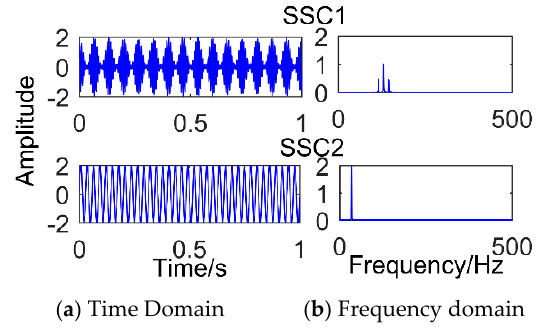
Figure 1. Time domain graph of Simulation signal, x1: sinusoidal signal; x2: Modulation signal; and x: Synthetic signal.